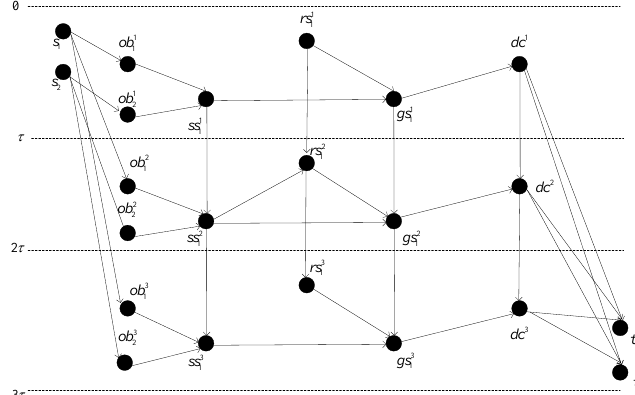
Figure 1. An example of extending TEG to network